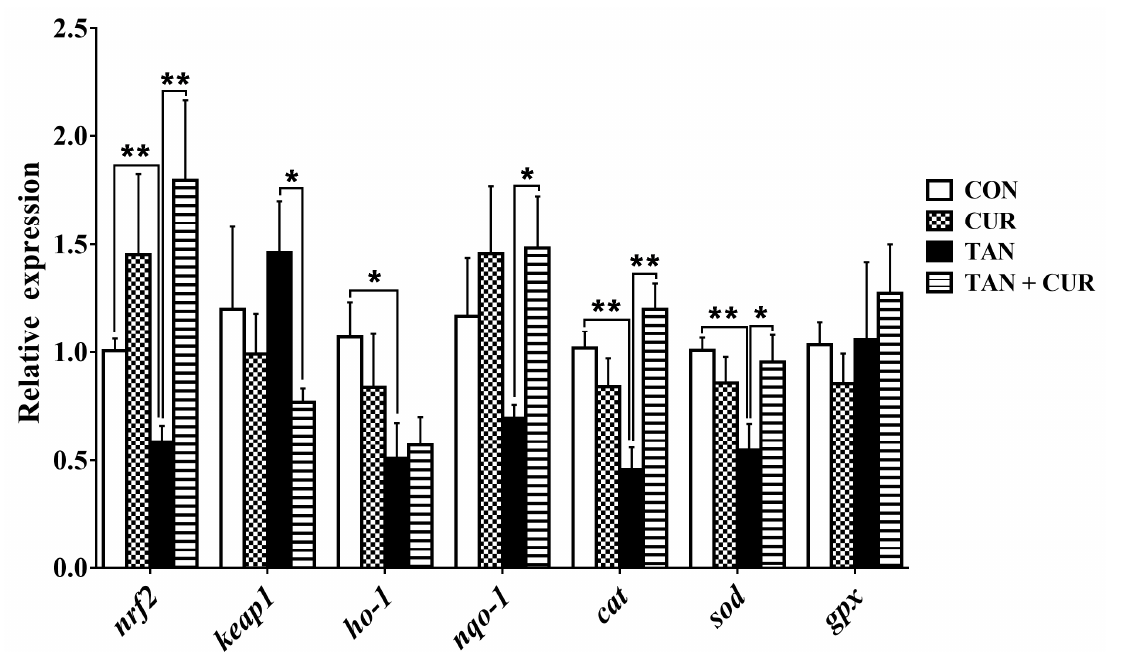
Figure 4. The mRNA levels of genes involved in the nuclear factor [erythroid-derived 2]-like 2 (Nrf2) signaling pathway in the normal and acute ammonia stress groups of gibel carp after feeding CUR diets for eight weeks. CON—control; CUR—curcumin; TAN—total ammonia nitrogen; TAN + CUR—total ammonia nitrogen + curcumin. keap1 —kelch-like ECH-associated protein-1; ho-1 — heme oxygenase-1; nqo-1 —NADPH quinine oxidoreductase-1; cat —catalase. The values are ex- pressed as the mean ± standard error ( n = 6). * p < 0.05; ** p < 0.01.